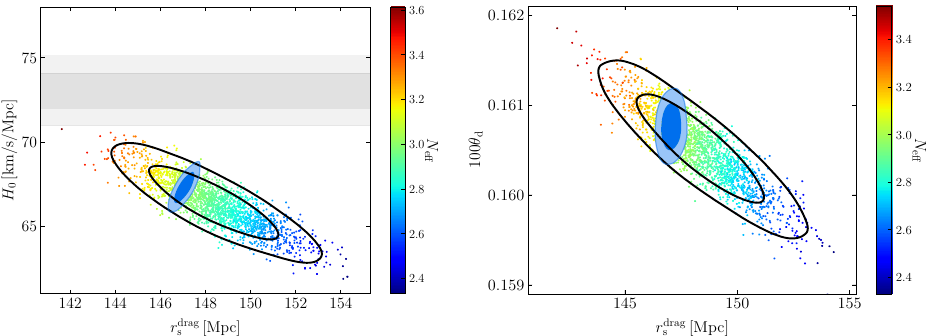
Figure 2. Marginalized 68% CL and 95% CL contours in the H 0 - r drag s plane ( left panel) and in the θ d - r drag s plane ( right panel) obtained by fitting Planck TT, TE, EE + low E to a pure Λ CDM model (blue filled contours), and to a model with varying N eff (black empty contours with points coloured according to the value of N eff ). Larger values of N eff get closer to the H 0 value preferred by SH0ES [37,38] (gray band) ( left panel). However, this implies a smaller value of r s , which is correlated with a larger value of θ d ( right panel). Note that here, the comoving sound horizon is computed at the end of baryon drag, which is slightly after recombination; therefore, r drag s is slightly larger than the r s of Figure